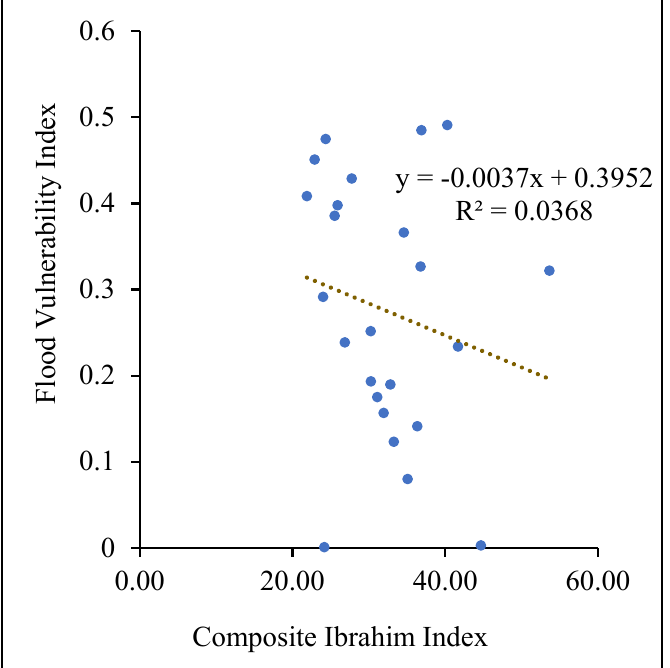
Figure 62. Relationship between composite Ibrahim index of development and composite flood vulnerability index in Nabadwip Municipality (2015).